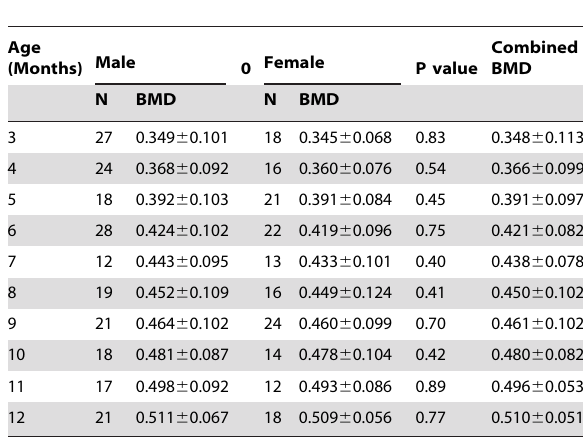
Table 3. BMD values of preterm infants at gestation-adjusted age of 3 , 12 months (g/cm 2 ) (X 6